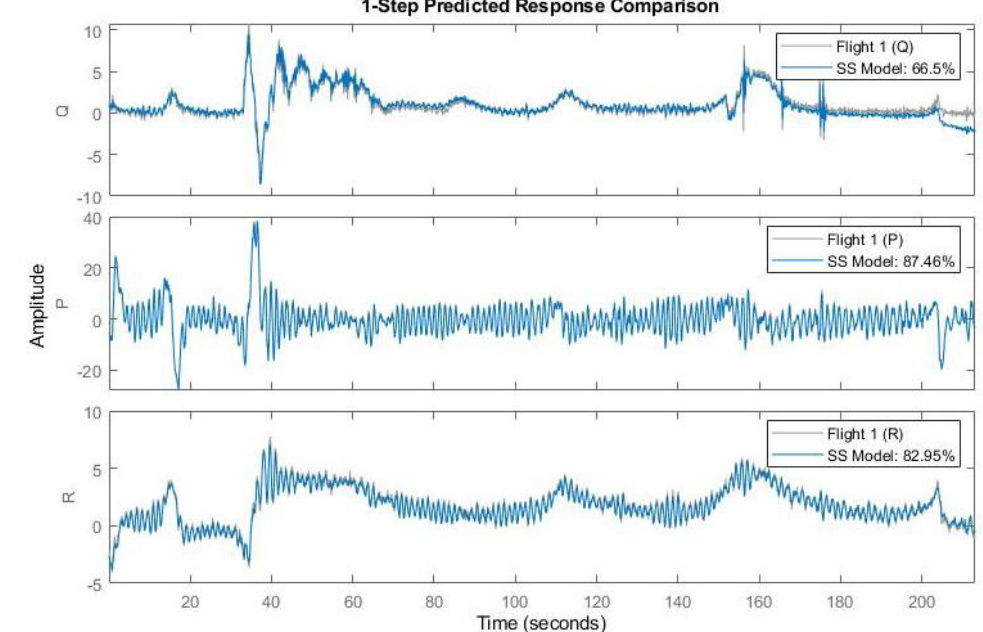
Figure 18. SS Model